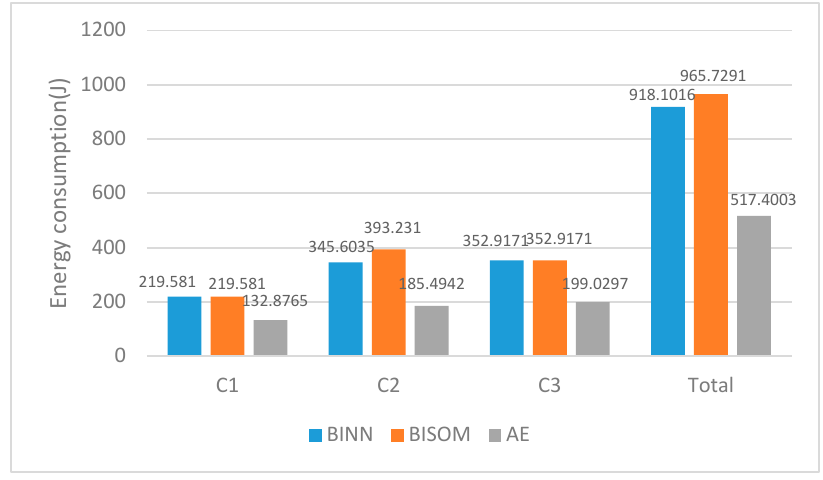
Figure 8. Actual energy consumption diagram of the AUV to the target location.